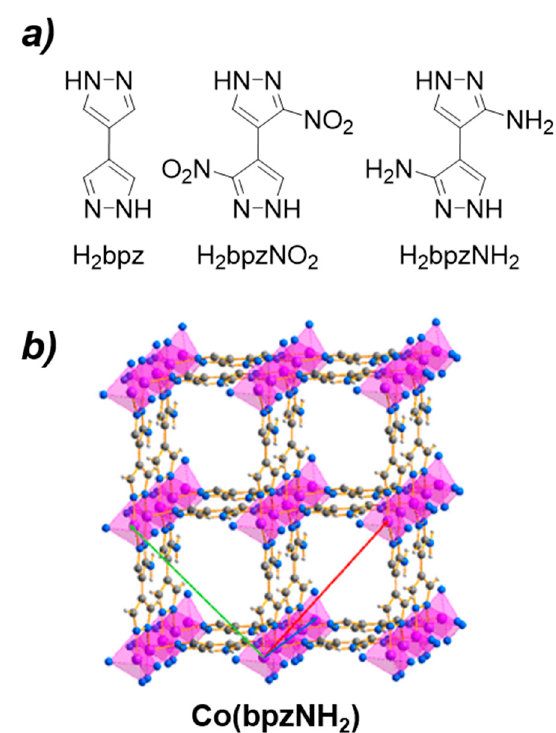
Figure 8. ( a ) The series of H 2 bpz derivatives. ( b ) Crystal structure of Co(bpzNH 2 ), which is isostructural to Co(bpz) and Co(bpzNO 2 ). Adapted with permission from reference [81]. ©2019 ACS.